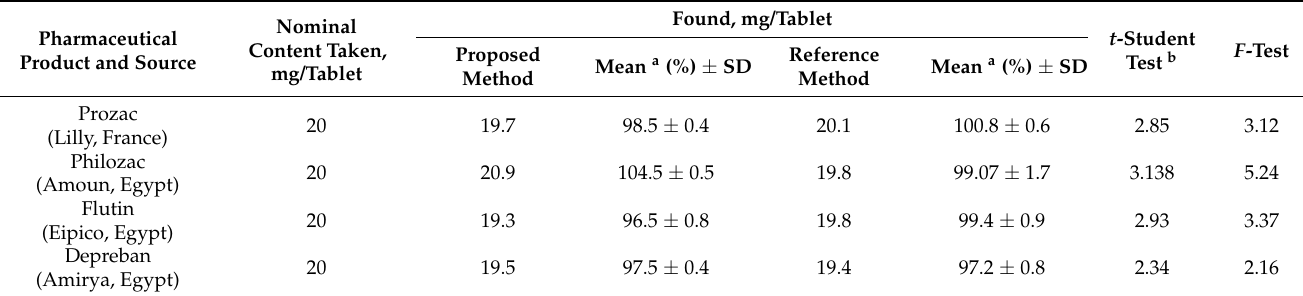
Table 7. Determination of FLX in different pharmaceutical preparations using ionophore (II) membrane-based sensor.